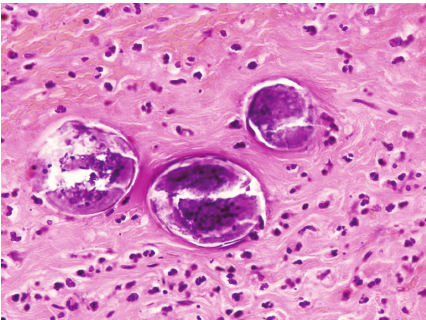
Figure 1: Para ffi n embedded 5 µ m thick section of appendiceal wall, process from the patient appendix. Magnified image by Light microscopy × 350 and stained with Haematoxylin and Eosin sa ff ron (H-E). The identification of a lateral spine on an oval egg (at the end of an oval egg) is consistent with S. mansoni .